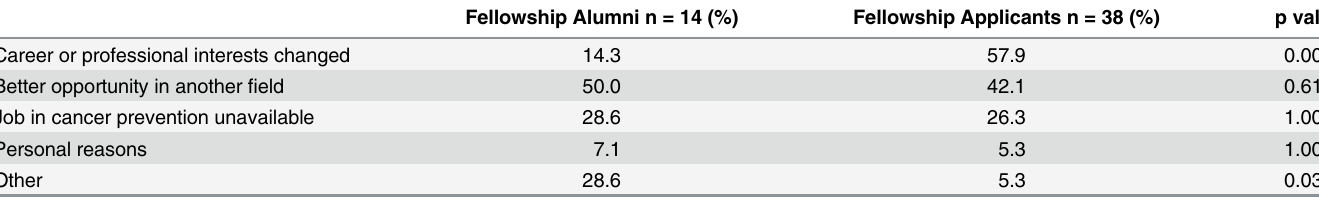
Table 4. Reasons for Not Currently Working in Cancer